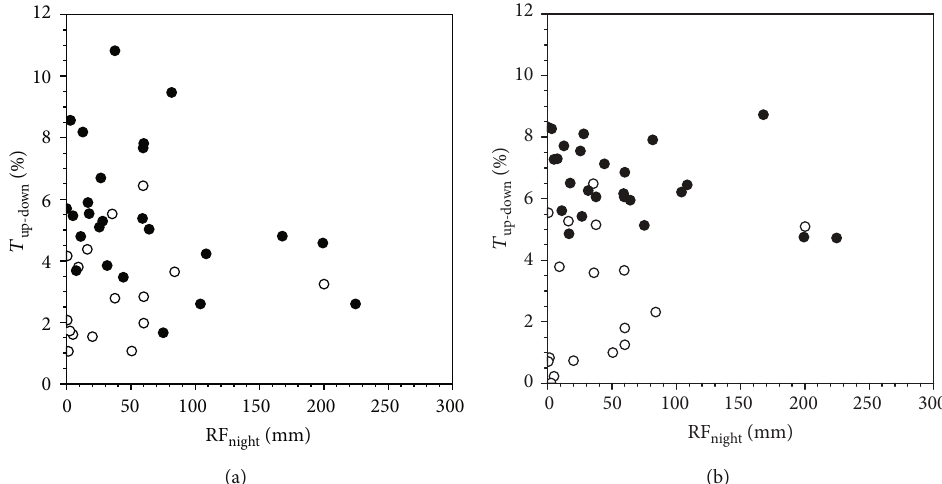
Figure 7: Relationship between the accumulated rainfall during the standby state for each measurement interval (accumulated for two weeks before each measurement) ( RF ) and the di ff erence in transmittance of the substrates on the downward and upward systems ( T night (a) PMMA and (b)